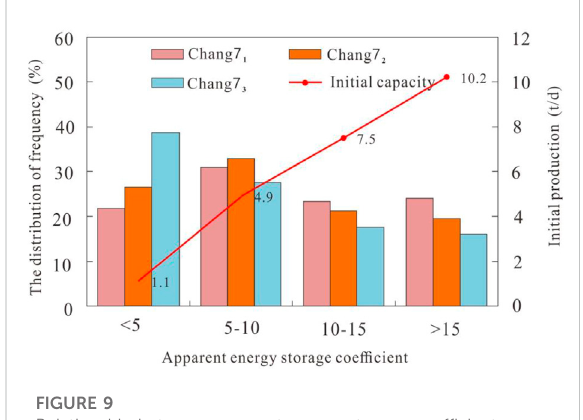
FIGURE 9 Relationship between apparent energy storage coef fi cient and initial production of the target